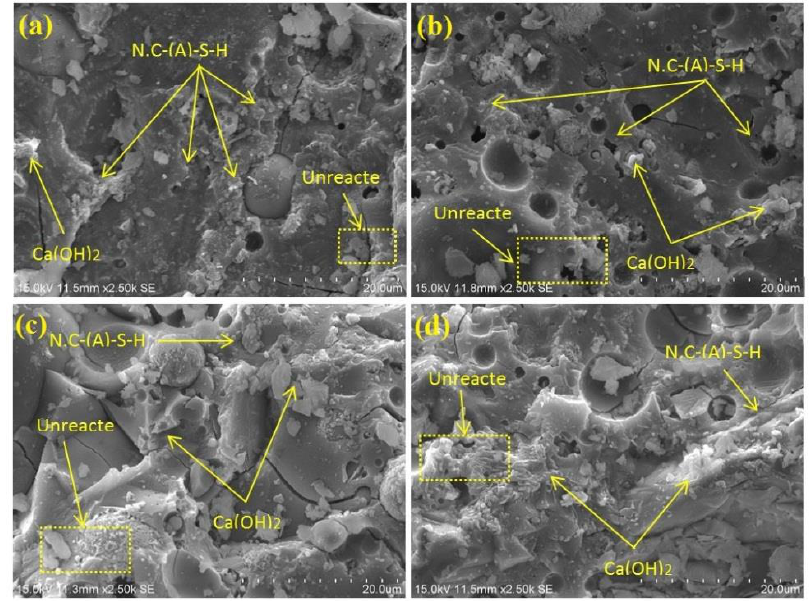
Figure 13. FESEM images of AAMs containing different proportions of BGWNP .